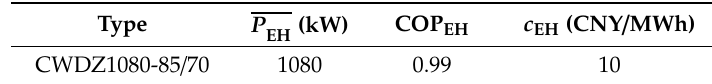
Table 8. Specification of EHs.